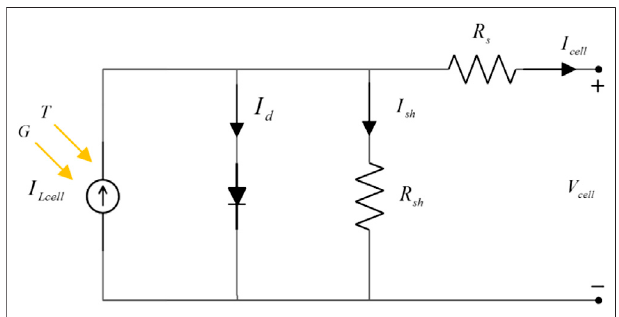
FIGURE 1 | Equivalent circuit of a single-diode based PV